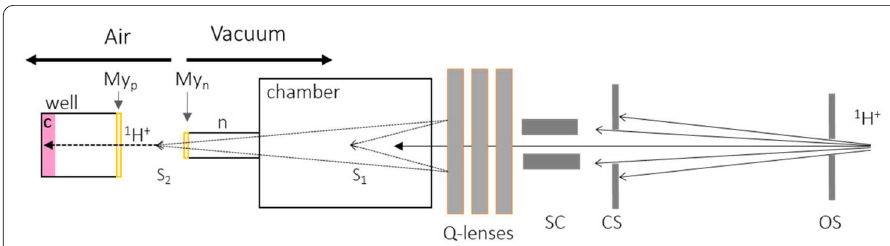
Figure 1 The IST nuclear microprobe schematic (not on scale) including the external beam setup used for cell irradiation. Object slits ( OS ); collimation slits ( CS ); magnetic quadrupole triplet ( Q-lenses ); focus plane inside the irradiation chamber (vacuum) and in-air ( S 1 ) and ( S 2 ), respectively; scanning coils ( SC ); exit nozzle ( n ) supporting a vacuum tight extraction window ( My n ). The schematic of the setup for cell irradiation in air represents one unit well of a typical 96-well plate for cell culture. In the used experimental configuration, the extracted 1 H + beam encountered the cell monolayer ( c ) after traversing the air path and a Mylar foil ( My p ) which covers the cell culture